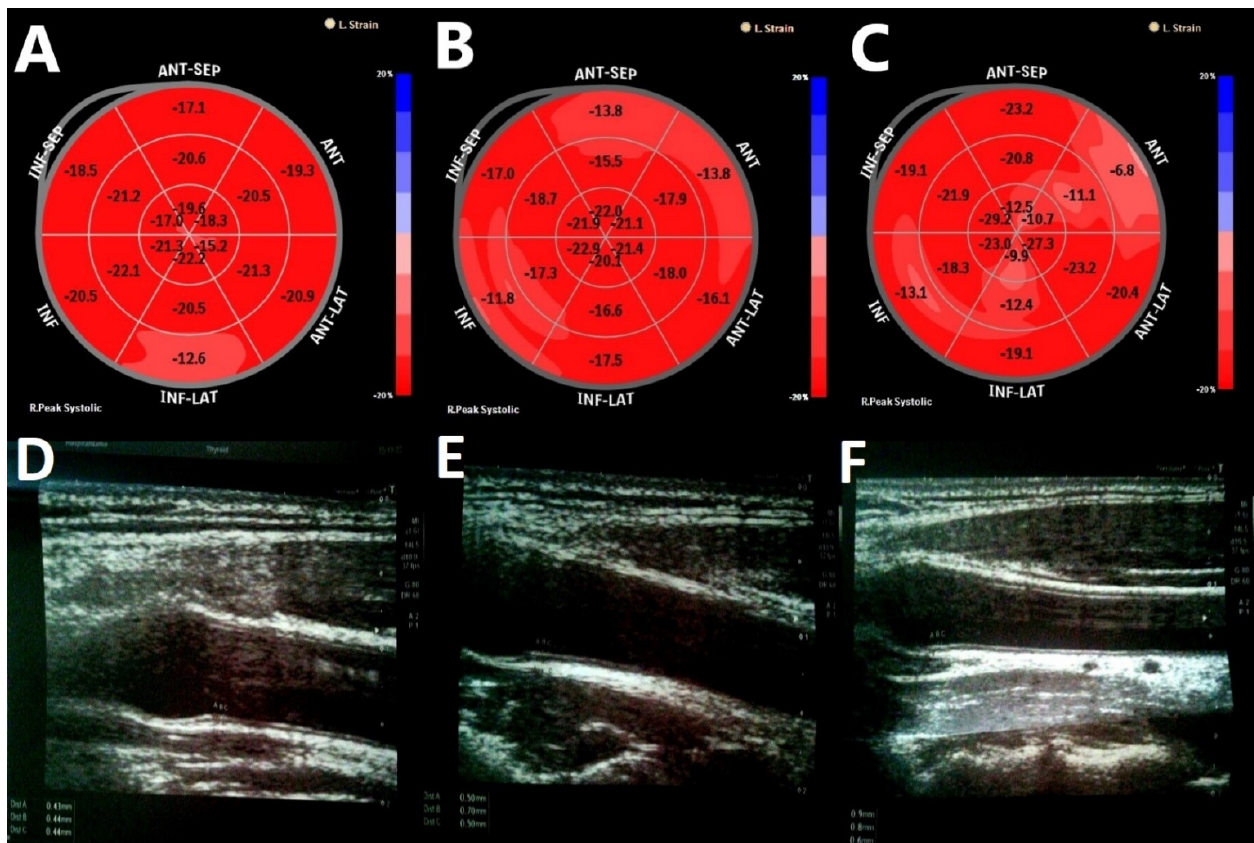
Figure 2. Left ventricular global longitudinal strain (GLS) in ( A ) a healthy subject, ( B ) women with exclusively type 1 diabetes mellitus (T1DM), ( C ) women with T1DM and Hashimoto’s disease (HD); and ultrasound images of carotid intima-media thickness (cIMT) measurement in ( D ) a healthy subject, ( E ) women with exclusively T1DM, and ( F ) women with T1DM and HD.